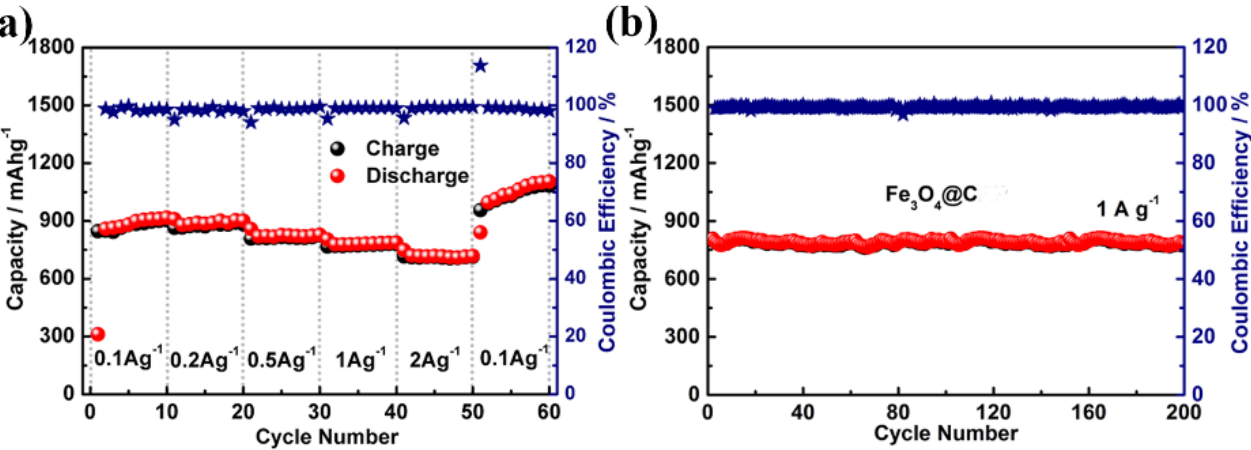
Figure 6. ( a ) Rate capability and CE of Fe 3 O 4 @C electrode at 0.1 to 2 A g − 1 ; ( b ) cycling stability and CE of Fe 3 O 4 @C at 1 A g − 1 for 200 cycles.